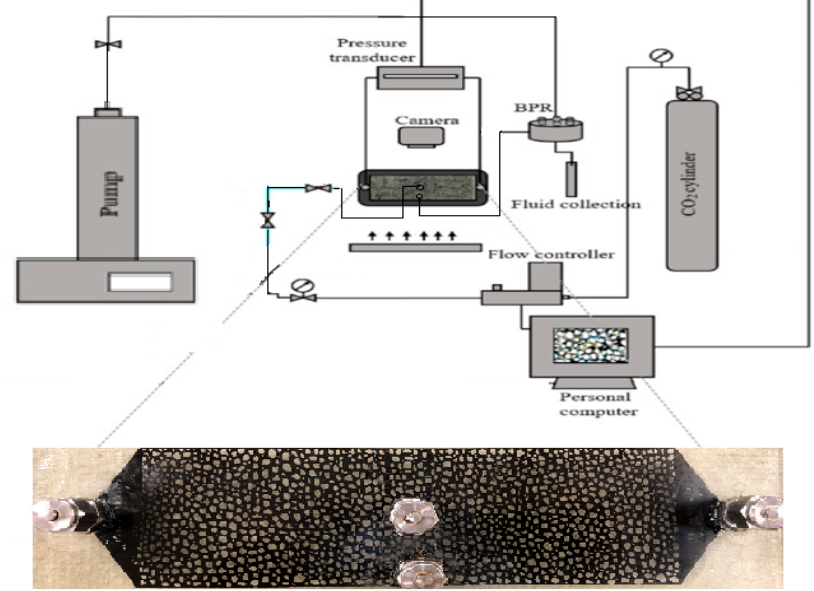
Figure 3. The design of a microfluidic model in AutoCAD.